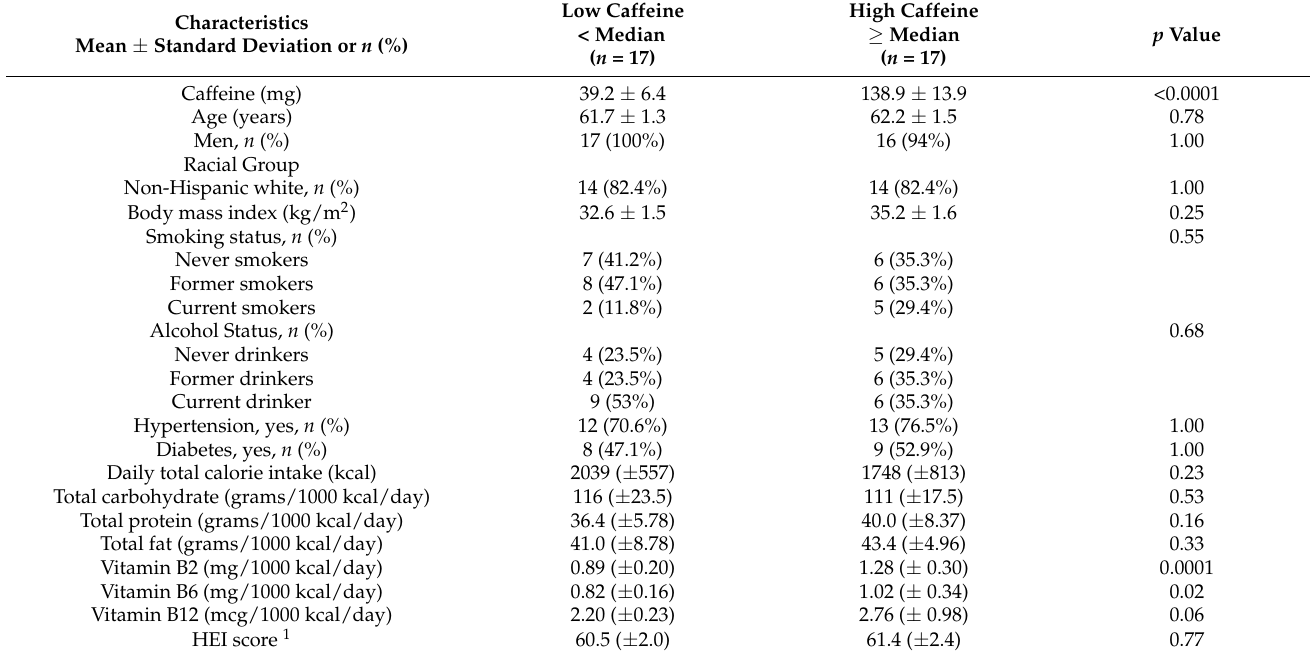
Table 1. Basic characteristics of study participants based on caffeine intake.